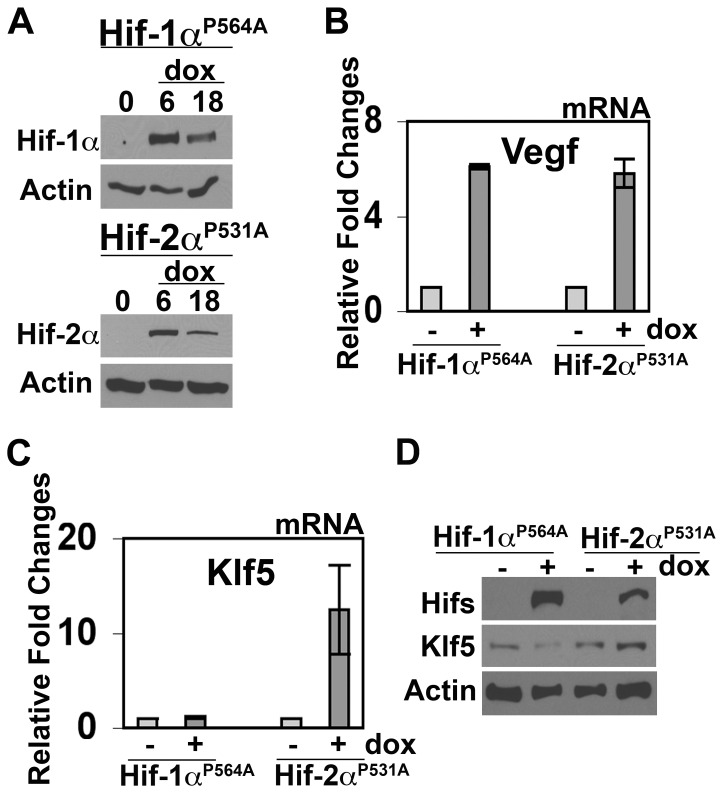
Hif-2αinduces Klf5-expression by glioma cells.(A) Normoxic Rt-glioma cells +/− 1µg/mL Dox treatment for 0–18hrs were analyzed by Western for the expression of degradation-resistant Hif-1αP564A and Hif-2αP531A. (B, C) Normoxic Rt-glioma cells were induced with 1µg/ml Dox for 6hrs or 18hrs and analyzed for Vegf (B) or Klf5 (C) mRNA expression by RT-QPCR, respectively. Data are expressed as fold changes relative to no Dox controls. Mean values +/− s.d. are shown; n = 3. (D) Normoxic Rt-glioma cells were induced with 1µg/ml Dox for 18hrs and Klf5 protein expression assessed by Western.